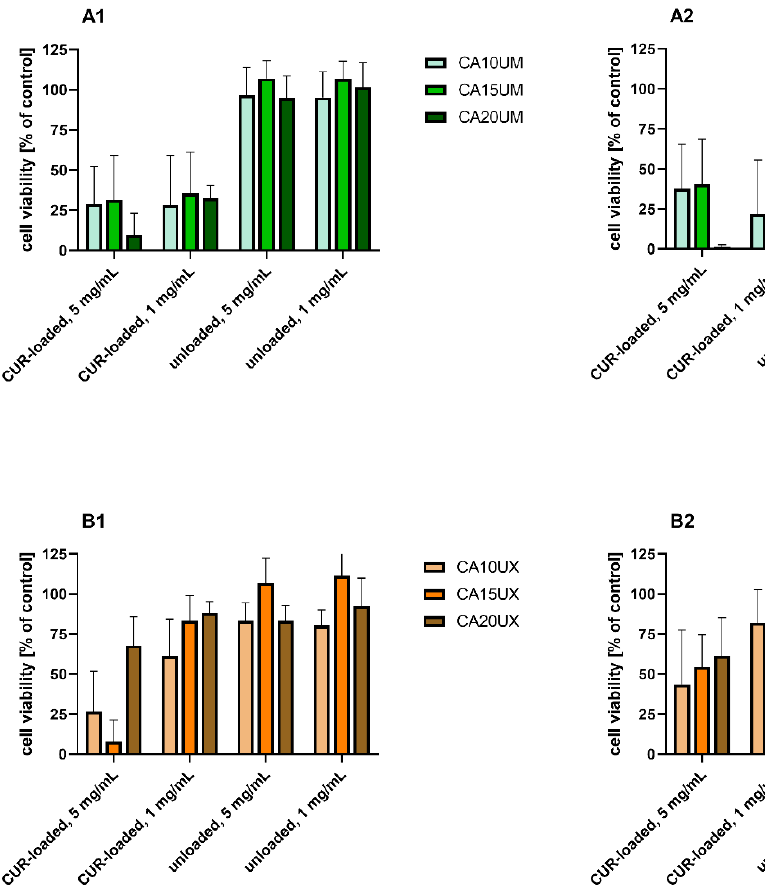
Figure 6. In vitro cytotoxicity of (A1) uncoated microparticles, (A2) CHIT-coated microparticles, (A3) GEL-coated microparticles, (B1) uncoated macroparticles, (B2) CHIT-coated macroparticles, (B3) GEL-coated macroparticles (see Table 1 for details of the particle composition). CUR-loaded and unloaded particles were added to human colon adenocarcinoma (LoVo) cells at two concentrations (1 and 5 mg/mL) for 24 h. Cell viability was evaluated using an MTT assay. The results are presented as the means ± S.D.